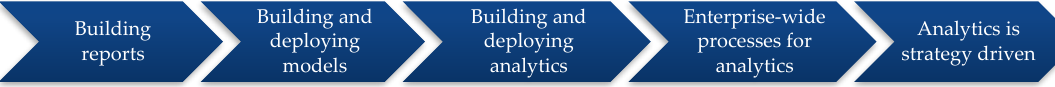
Figure 3. Analytic Processes Maturity Model (APMM)—five maturity levels of organizations. Source: own elaboration based on APMM.